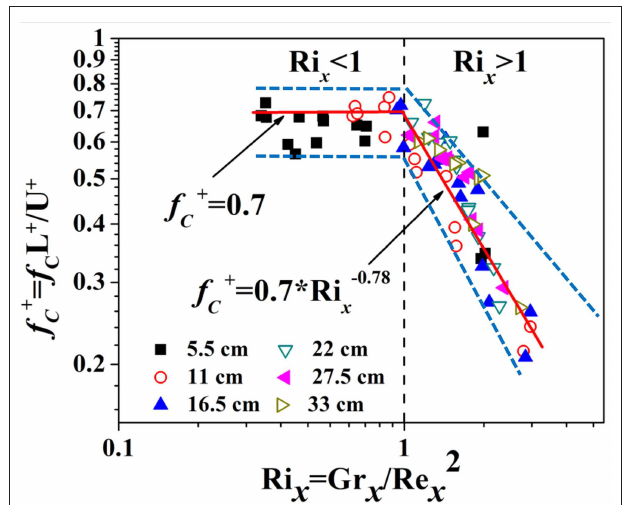
FIGURE 8 | Non-dimensional frequency f + C with local Ri x . Dashed lines indicate for Ri x < 1, f + C mostly varies from 0.55 to 0.8, for Ri x > 1, f + C mostly varies from 0.55Ri − 0.6 to 0.8Ri − 0.78